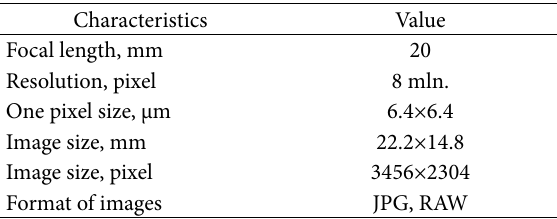
Table 1. Characteristics of Canon EOS 350D digital